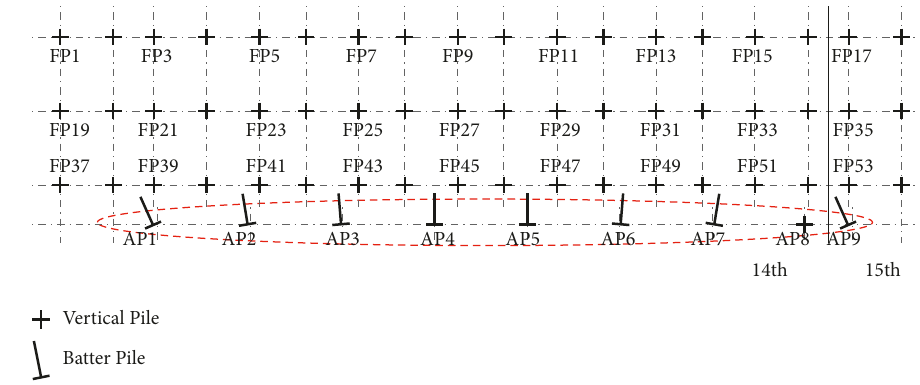
Figure 12: Piles at the junction of the front and the rear bearing